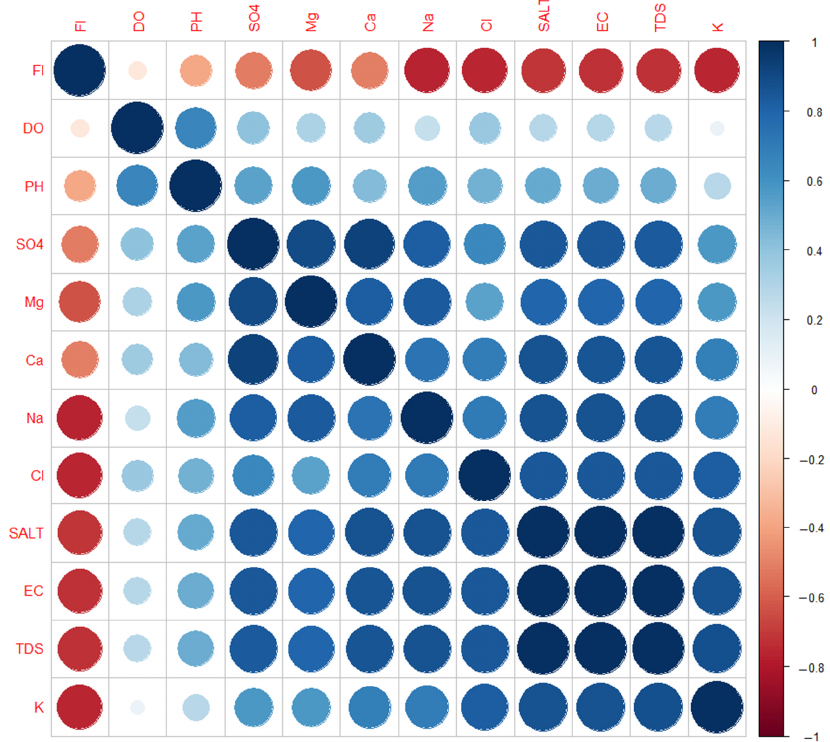
Figure 6. Correlation matrix between physicochemical parameters and trace metals, Pearson correlation test values are shown as correlation coefficients (above diagonals and shown by color and intensity of shading in pie charts and squares) and p -values (below diagonal).